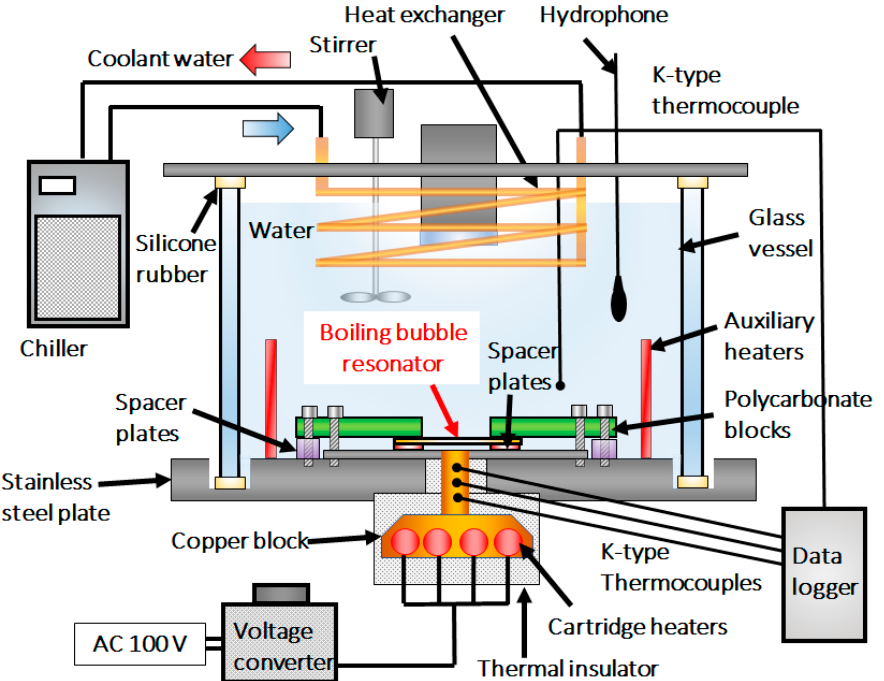
Figure 1. Experimental apparatus for subcooled pool boiling with a boiling bubble resonator (BBR) at atmospheric pressure.